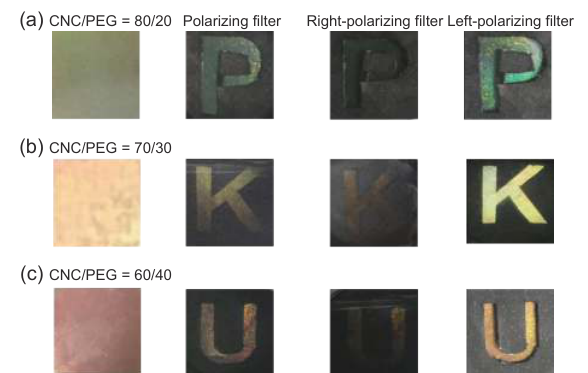
Figure 7 Pictures of CNC/PEG/EuW 10 composite films with (a) CNC/PEG = 80/20, (b) CNC/PEG = 70/30, and (c) CNC/PEG = 60/40, viewed through a polarizing filter (column 2), viewed through a right-polarizing filter (column 3) and viewed through a left- polarizing filter (column